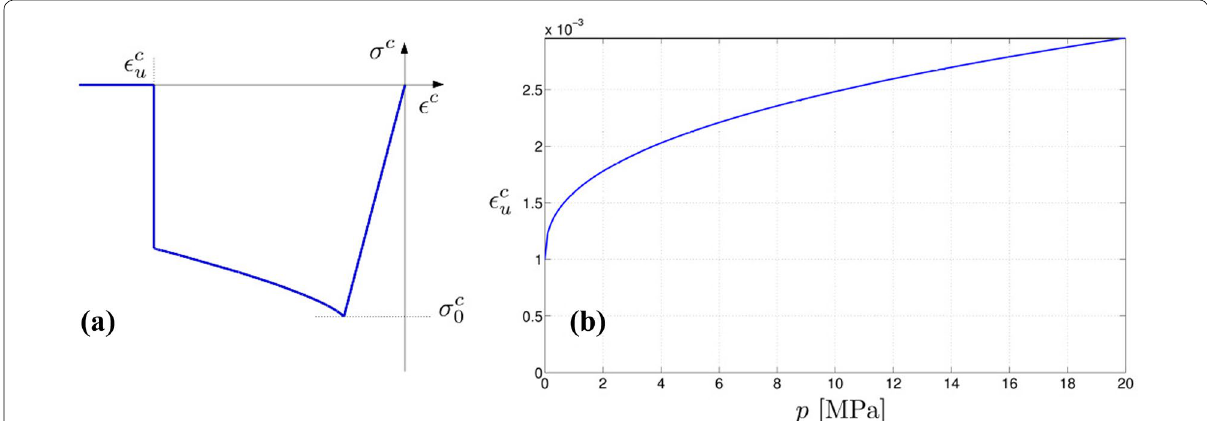
Fig. 3 a Unidimensional representation of the concrete constitutive model and b variation of the ultimate strain in concrete as a function of the hydrostatic pressure, according to Eq. (8) and the parameter set used in Sect.